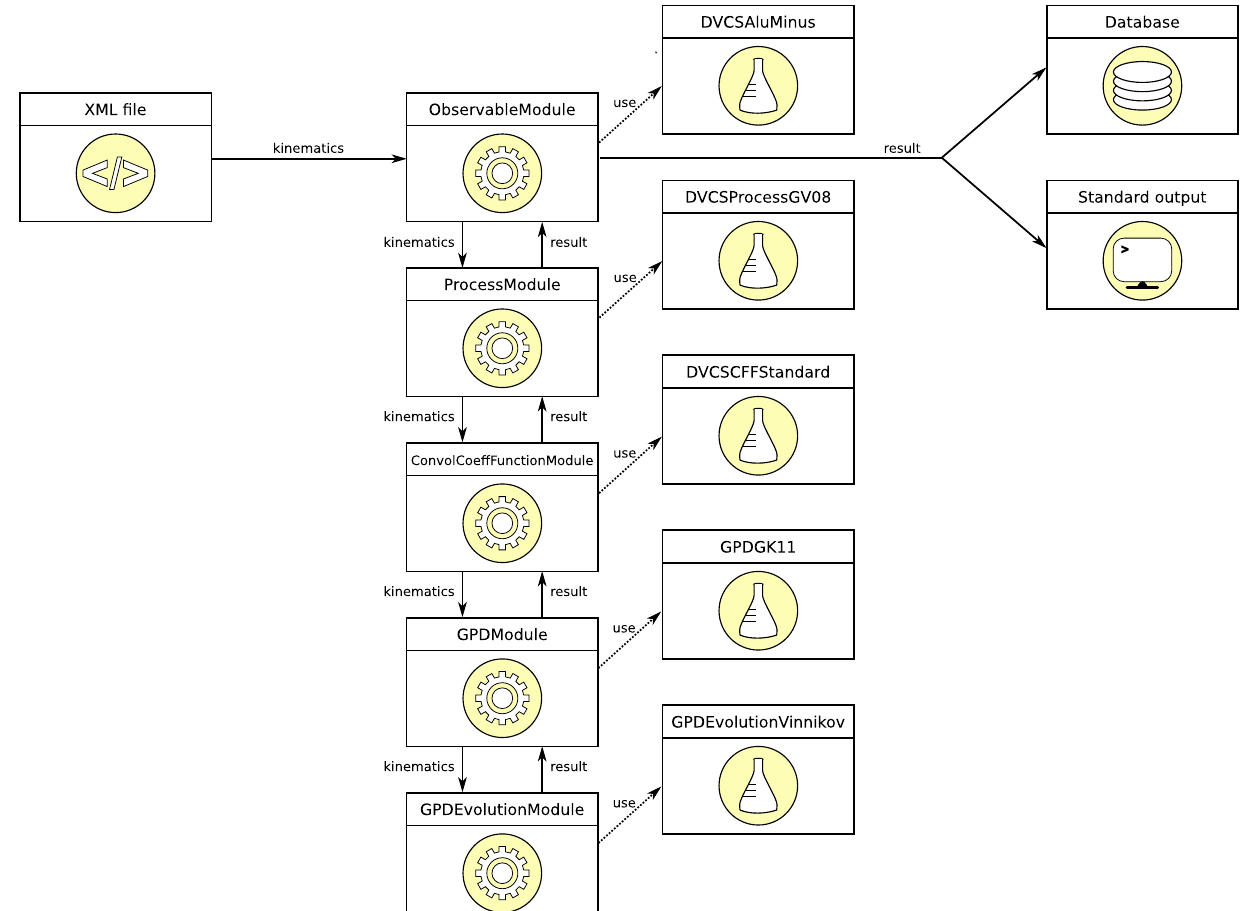
Fig. 8 Principle of automation: computation of a beam spin asymmetry